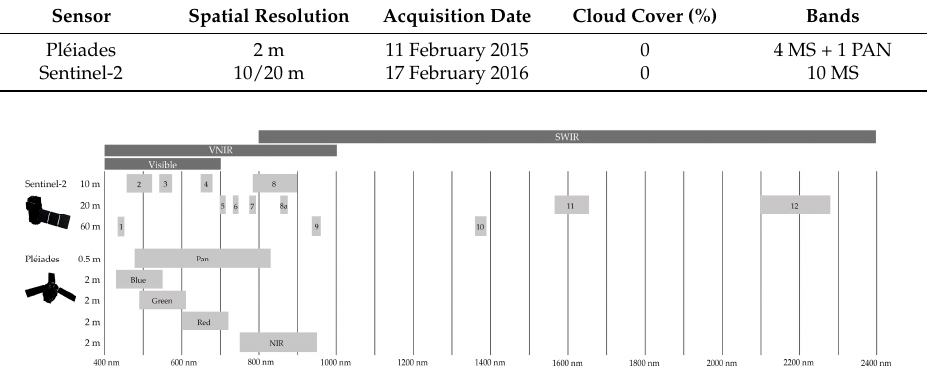
Figure 3. Overview of spectral and spatial resolution of Sentinel-2 and Pléiades.